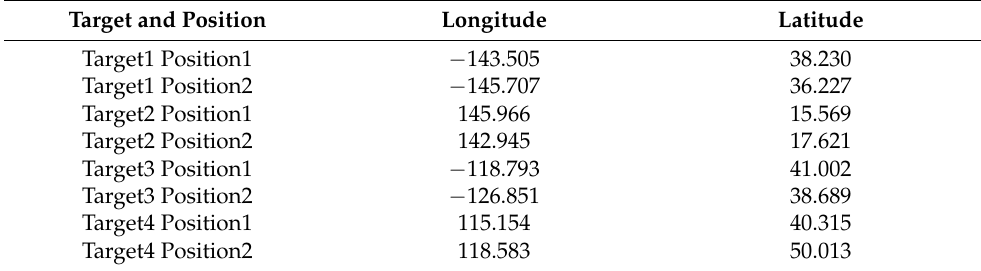
Table 4. Coordinate of the trajectory shadow ends.